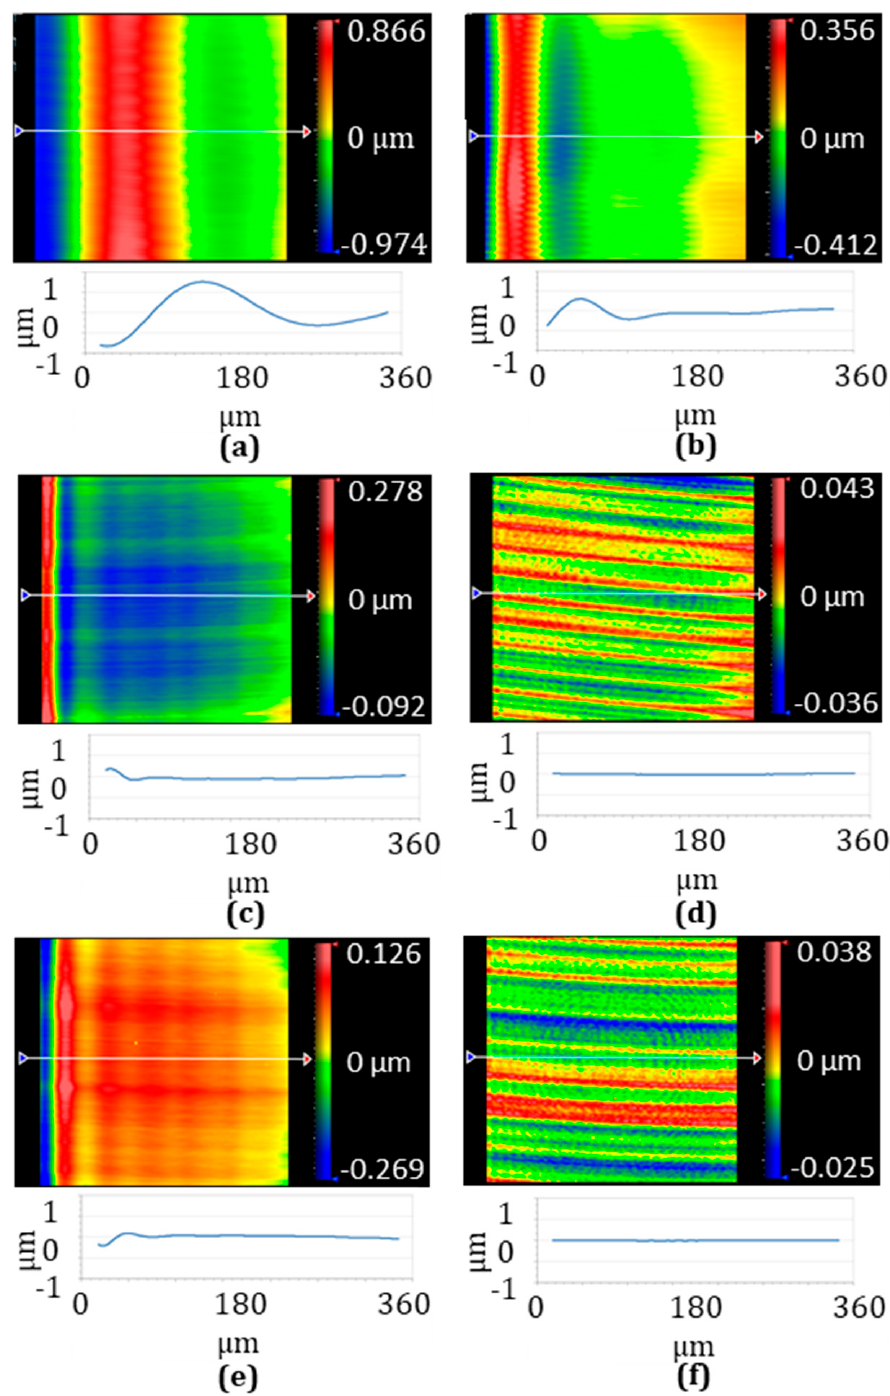
Figure 10. Surface error after removing the designed spherical shape for the lenslet in Figure 9. Similarly, convex lenslet arrays with ( a ) 0.25° constant-angle sampling and 0.001 s inverse time feed, ( b ) 0.25° constant-angle sampling and 0.004 s inverse time feed, ( c ) 2.5 µm constant-arc sampling and 0.001 s inverse time feed, ( d ) 2.5 µm constant-arc sampling and 0.004 s inverse time feed, ( e ) concave lenslet array with 2.5 µm constant-arc sampling and 0.001 s inverse time feed, and ( f ) convex lens array with 2.5 µm constant-arc sampling in the outer region and 0.25° constant-angle sampling in the center region and 0.004 s inverse time feed.